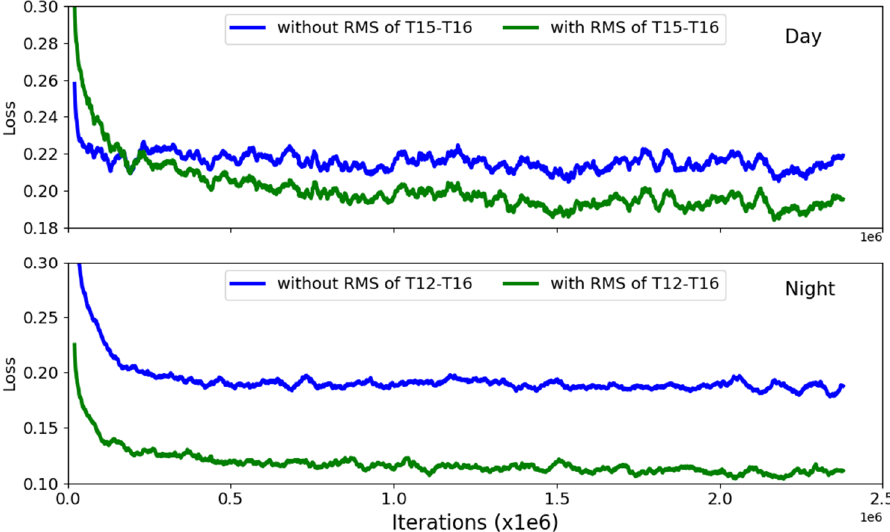
Figure 5. The changes in cost function for day (upper) and night (bottom) during FCDN_CSM training with and without the RMS 12–16 or RMS 15–16 as a new feature.